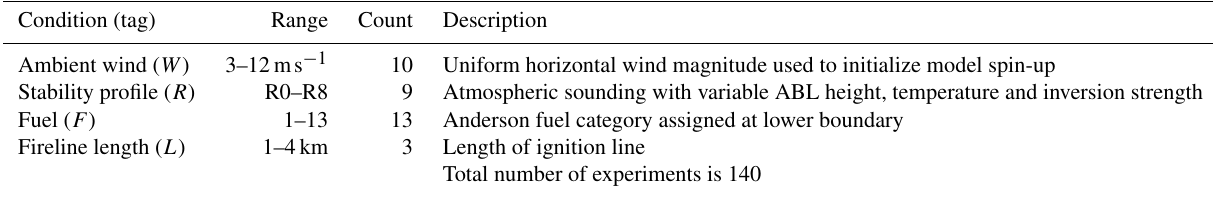
Table 2. Test conditions included in the synthetic plume dataset. The count indicates the number of unique values used within the specified